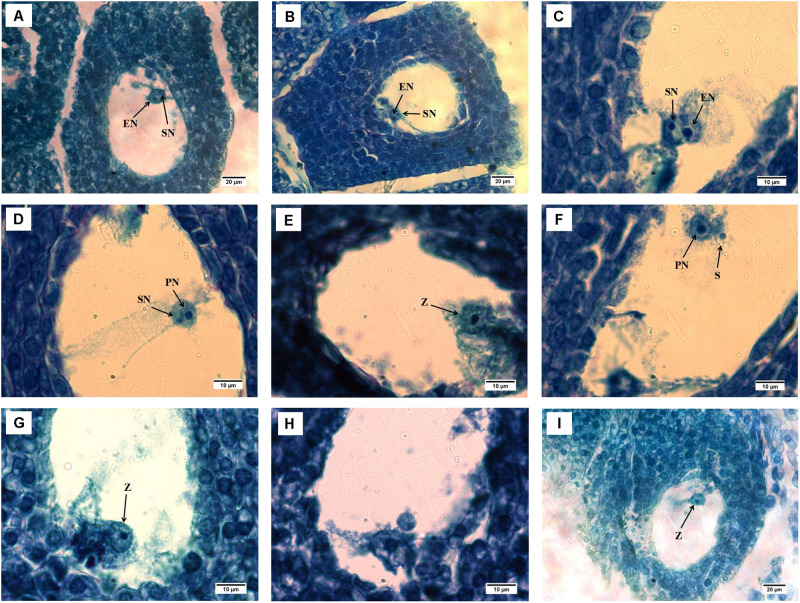
Stained paraffin sections of the double fertilization process.A. 177 sperm nucleus is close to the egg nucleus 4 days after pollination; B. 177 × 53 sperm nucleus is close to the egg nucleus 4 days after pollination; C. 177 × Y11 sperm nucleus is close to the egg nucleus 4 days after pollination; D. 177 spermatic nucleus is close to the polar nucleus 6 days after pollination; E. 177 × 53 sperm cells are close to the polar nucleus 6 days after pollination; F. 177 × Y11 sperm cells are close to the polar nucleus 6 days after pollination; G. 177 sperm and egg nuclei are fused 6 days after pollination; H. 177 × 53 sperm and egg nuclei are fused 6 days after pollination; I. 177 × Y11 sperm and egg nuclei are fused. J. 177 primary endosperm nucleus enters a stage of division 10 days after pollination. E: Egg cell; Sy: Synergid cell; EN: Egg nucleus; SN: Sperm nucleus; PN: Polar nucleus; S: Sperm; Z: Zygote.